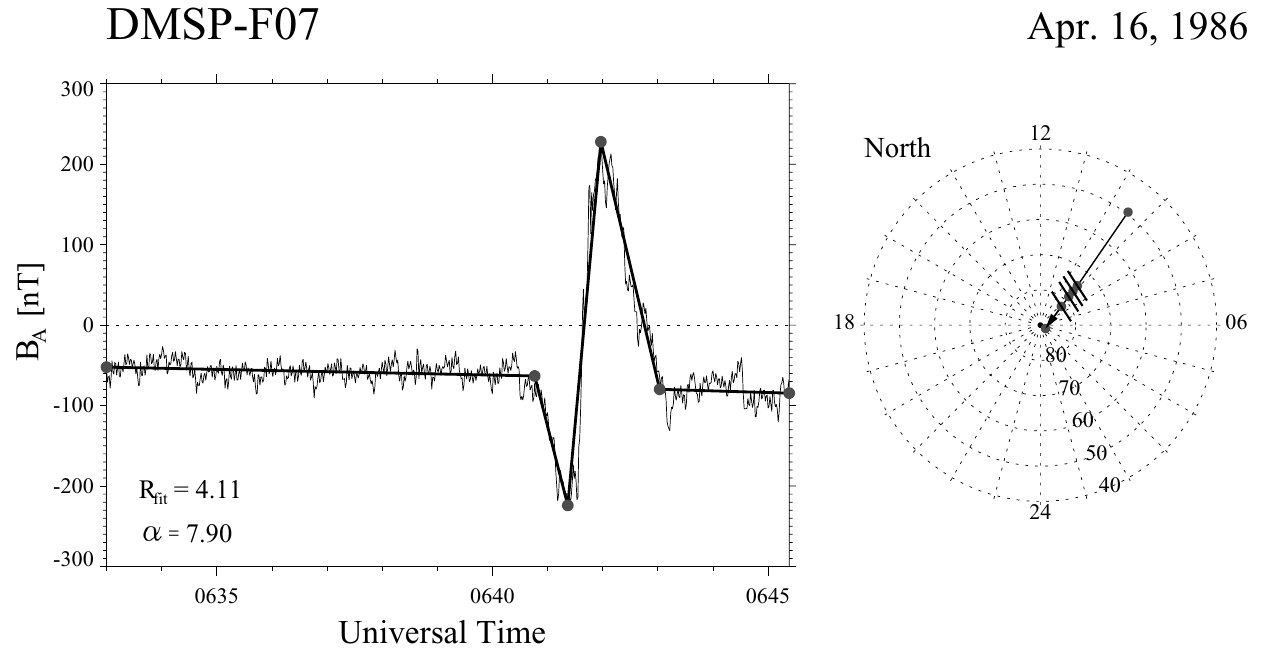
Figure 1 Fig. 1. Left panel: An example of time-domain plot of B A measured by the DMSP-F7 satellite on the dayside in the Northern Hemisphere for the orbit of 16 April, 1986. The thin line shows the raw data of B A , and thick line shows the line fitted by the prodecure of Higuchi and Ohtani (2000) (see text for details). The three slopes in this figure correspond to upward R2, downward R1 and upward R0, from left to right. Right panel: Shows the orbit of the path used in the right panel. Grey dots show the node points of the segment fit, and the segments on the four of the dots show the direction of maximum variance in the magnetic field; B A is measured along the